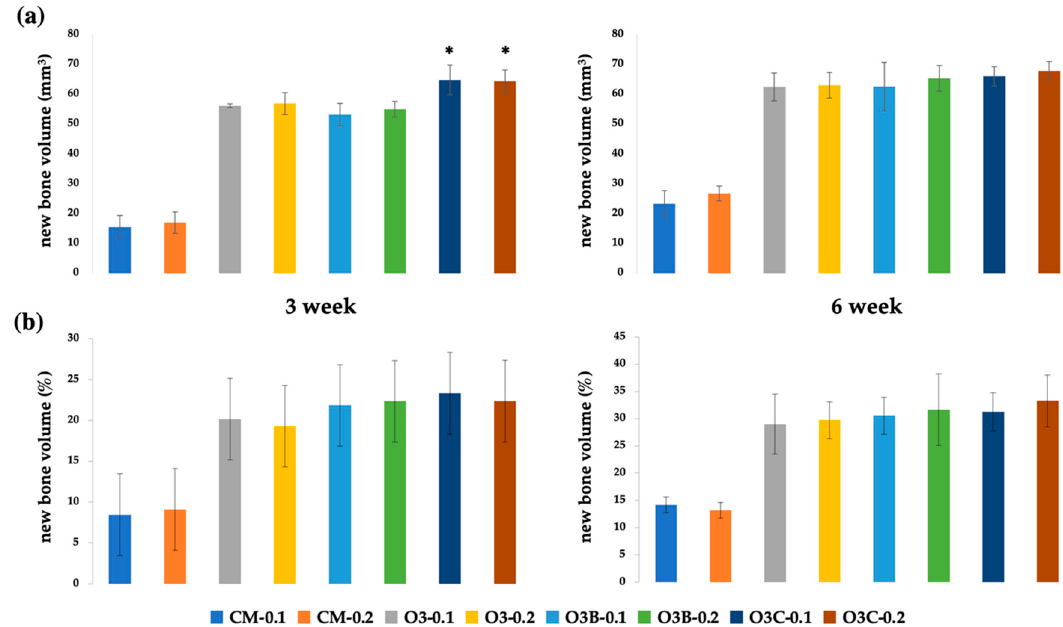
Figure 1. Evaluation of bone formation via radiological analysis and histomorphometric analysis. ( a ) radiological analysis; ( b ) histomorphometric analysis. rhBMP-2, recombinant human bone morphogenetic protein 2; BCP, biphasic ceramic phosphate scaffold; *, At the same concentration of rhBMP-2, bone formation occurred to a greater extent in BCP collagen than in BCP block and BCP powder at 3 weeks POD ( p < 0.05); CM-0.1, no graft containing 0.1 mg/mL rhBMP-2; CM-0.2, no graft containing 0.2 mg/mL rhBMP-2; O3-0.1, BCP powder containing 0.1 mg/mL rhBMP-2; O3-0.2, BCP powder containing 0.2 mg/mL rhBMP-2; O3B-0.1, BCP block containing 0.1 mg/mL rhBMP-2; O3B-0.2, BCP block containing 0.2 mg/mL rhBMP-2; O3C-0.1, collagen-added BCP containing 0.1 mg/mL rhBMP-2; O3C-0.2, collagen-added BCP containing 0.2 mg/mL rhBMP-2.